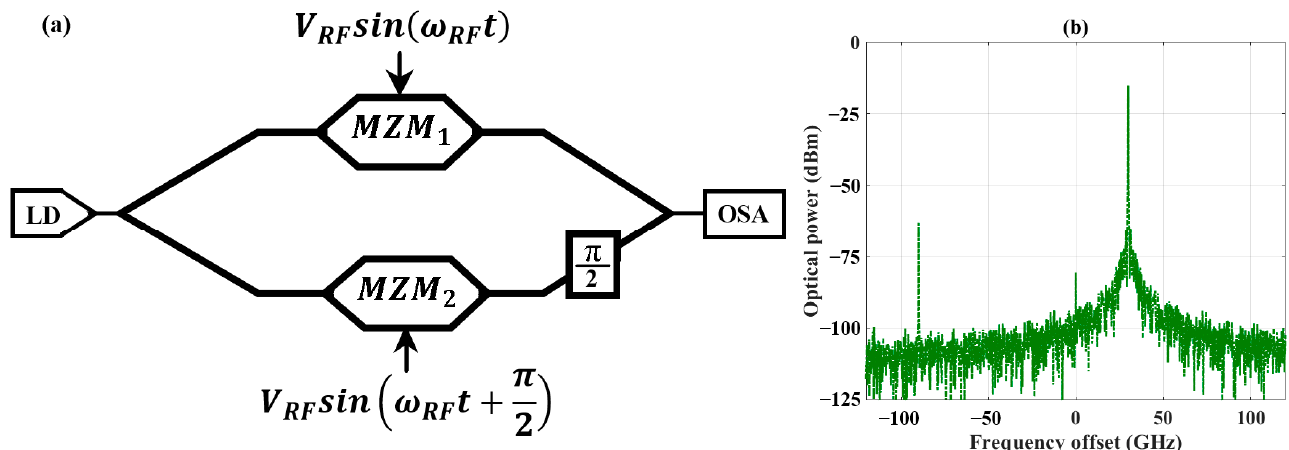
Figure 1. ( a ) Schematic diagram of conventional optical frequency shifter; ( b ) optical spectrum of the circuit showing the up-converted carrier shifted by RF frequency 30 GHz. Simulation is carried out using Virtual photonics Inc. (VPI) software package. MZM, Mach-Zehnder modulator; OSA, optical spectrum analyzer; LD, laser diode.